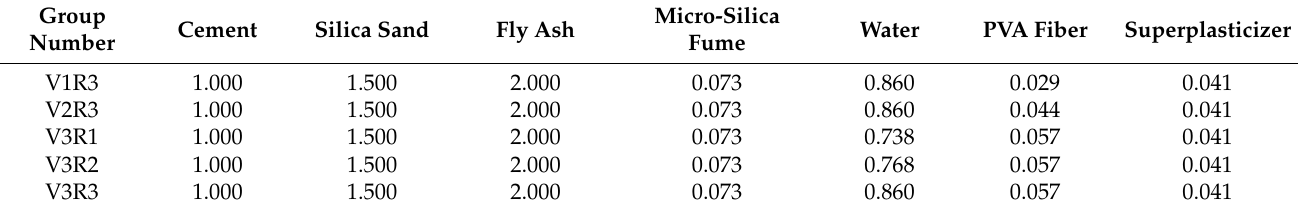
Table 1. ECC mix proportion.